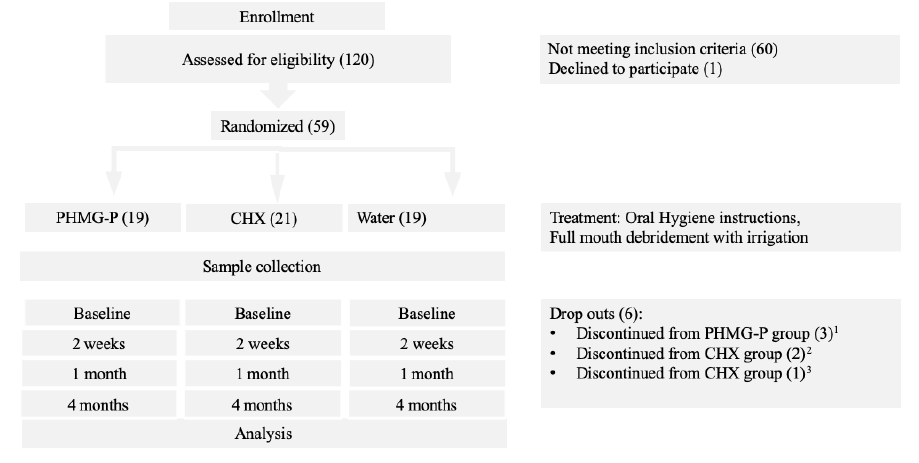
Figure 1. Study flow chart.